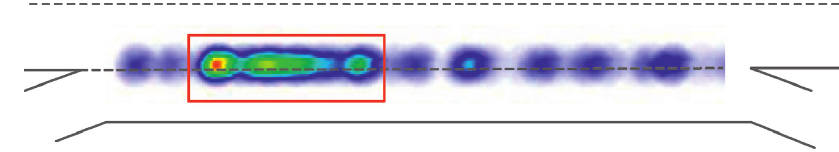
Figure 10: Lane-changing location heat map.